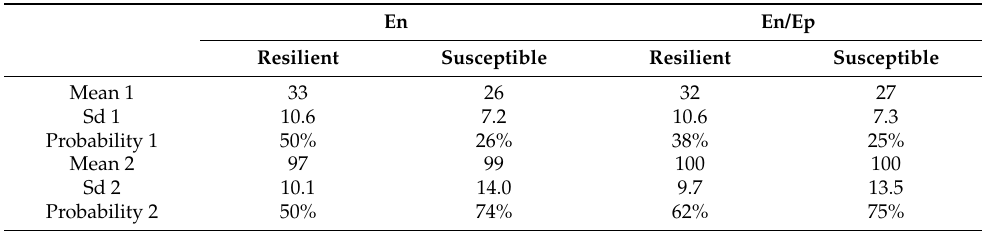
Table 3. Conception rates obtained from the data in the included farm from March 2016 to March 2019. Rates were obtained by splitting the observation period into an endemic period (from March 2016 to May 2018) and endemic and epidemic period (from March 2016 to March 2019). En En/Ep Resilient Susceptible Resilient